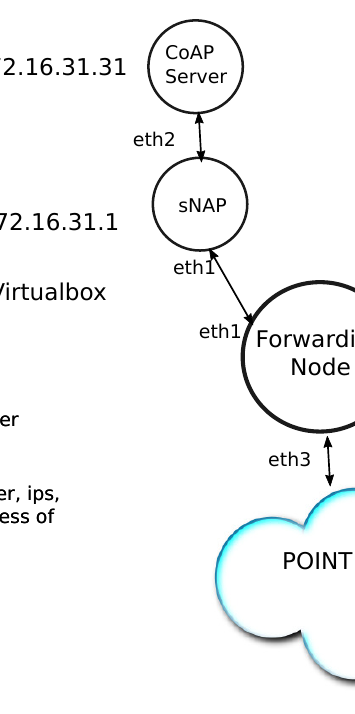
Figure 4. A simple IoT test